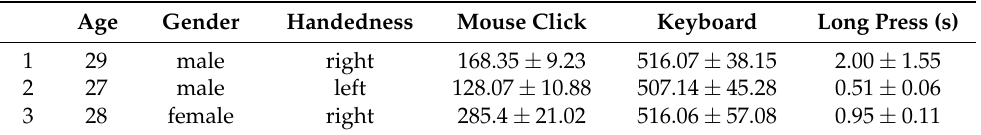
Table 2. Anthropomorphic data and calibration data of participants. Columns two to four contain the anthropomorphic data of each participant. Calibration data are provided in columns five to seven as M ± SD, with the values for mouse click and keyboard calibration being abstract nonlinear force values measured by the FSRs within a range of